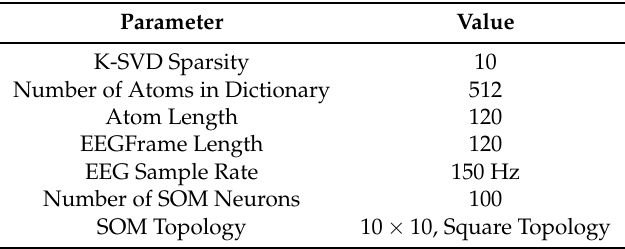
Table 1. Parameters in Feature